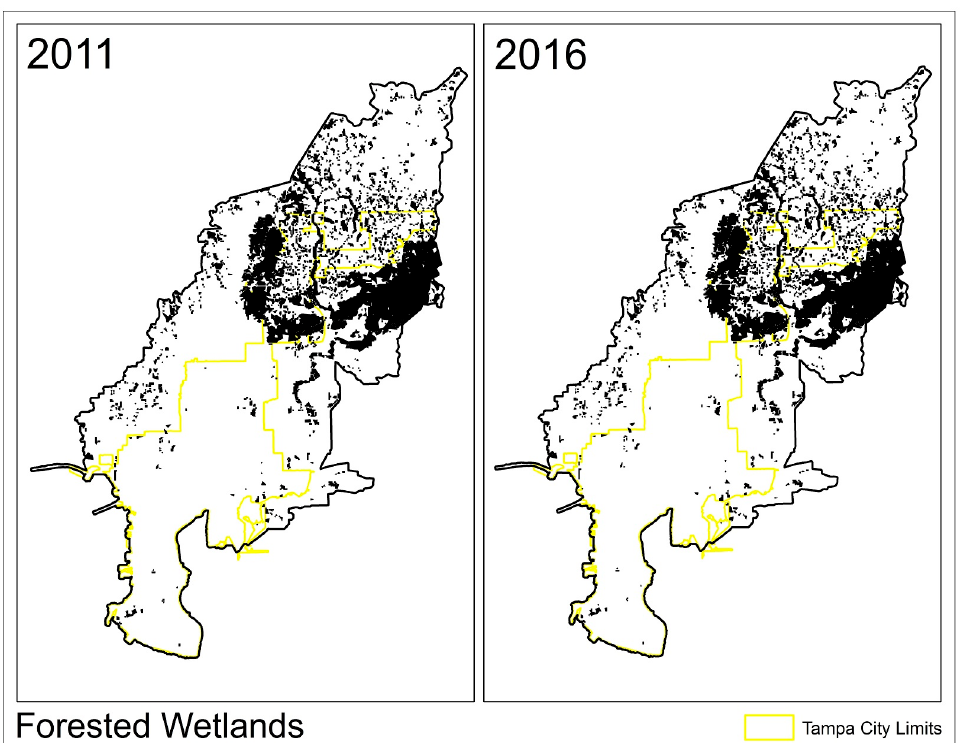
Figure A13. Observed (2011) and Modeled (2016) LULC distribution for the “Forested Wetlands” class.